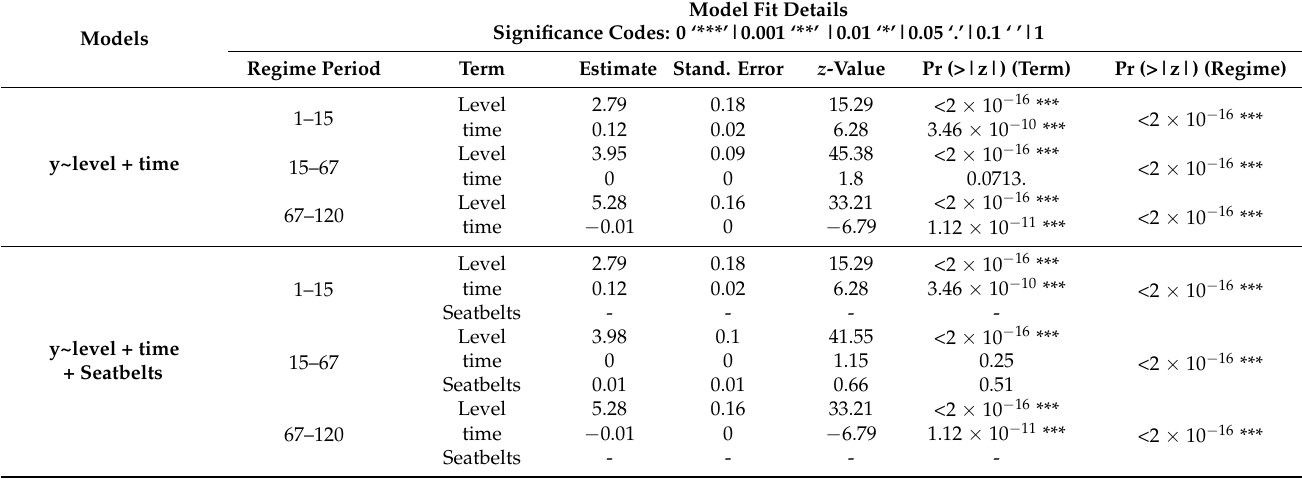
Table 5. Fitted segmented model details (minimal base model